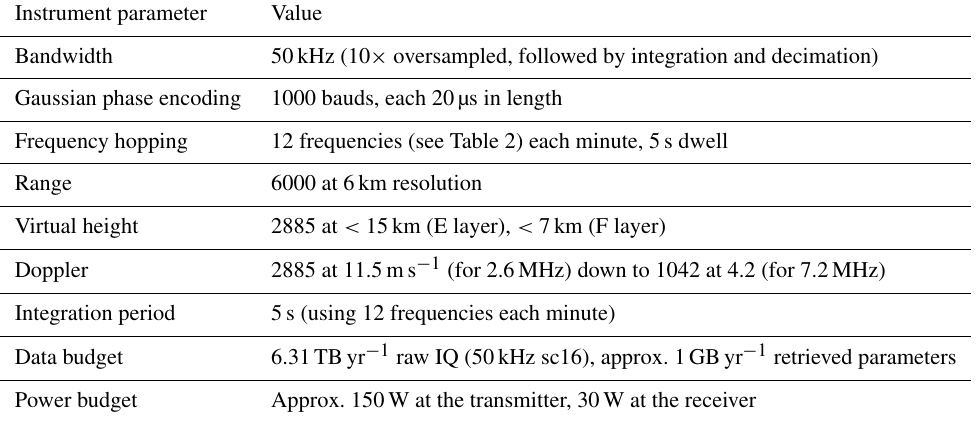
Table 1. Instrument